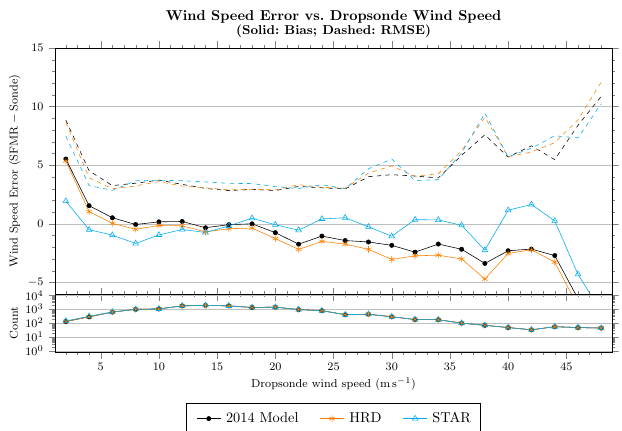
Figure 5. Wind-speed error (SFMR - dropsonde) as a function of dropsonde surface wind-speed (U 10N ) estimate for retrievals using the model from Klotz and Uhlhorn [8] (“2014 model”), the HRD dataset, and the STAR algorithm. Please note that the STAR algorithm includes the models from Sections 2.3 and 2.4. Solid lines and symbols indicate means and dashed lines indicate the RMS error on the upper panel. The lower panel shows a histogram of the collocated data. Only collocations where all sources are available are